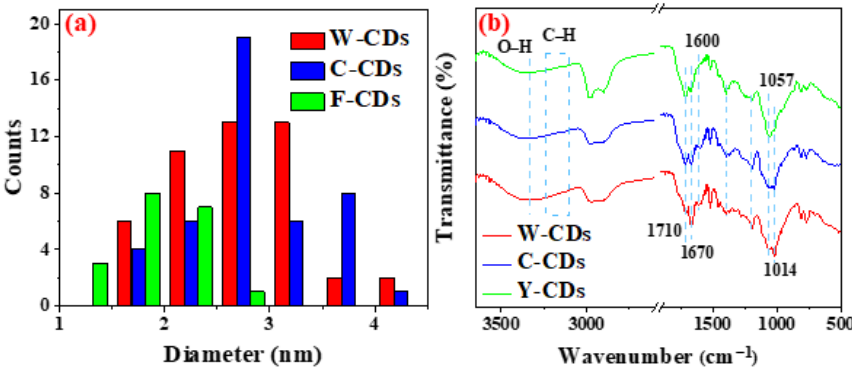
Figure 2. Size distribution of the As-prepared CDs ( a ) and the FTIR spectra of the CDs ( b ).